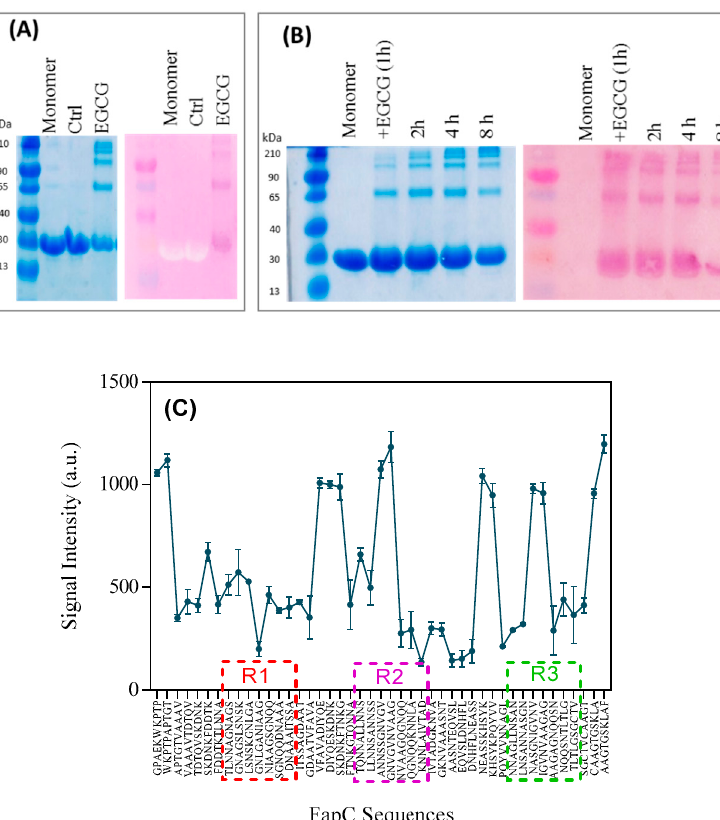
Figure 6. NBT-assay demonstrating polyphenol interactions with FapC. ( A ) Right: SDS-PAGE of oligomers separated by SEC, left: A copy of the same SDS-PAGE gel was electroblotted onto PVDF membrane and stained with NBT; ( B ) time study of the EGCG-FapC interaction using (right) SDS-PAGE) and (left) NBT-stained PVDF membrane, respectively. Samples were taken out at the indicated times and frozen before running on the gel; ( C ) signal intensities of peptide array displaying peptides corresponding to di ff erent sequences of FapC, incubated with EGCG, and stained with NBT to identify interacting sequences.